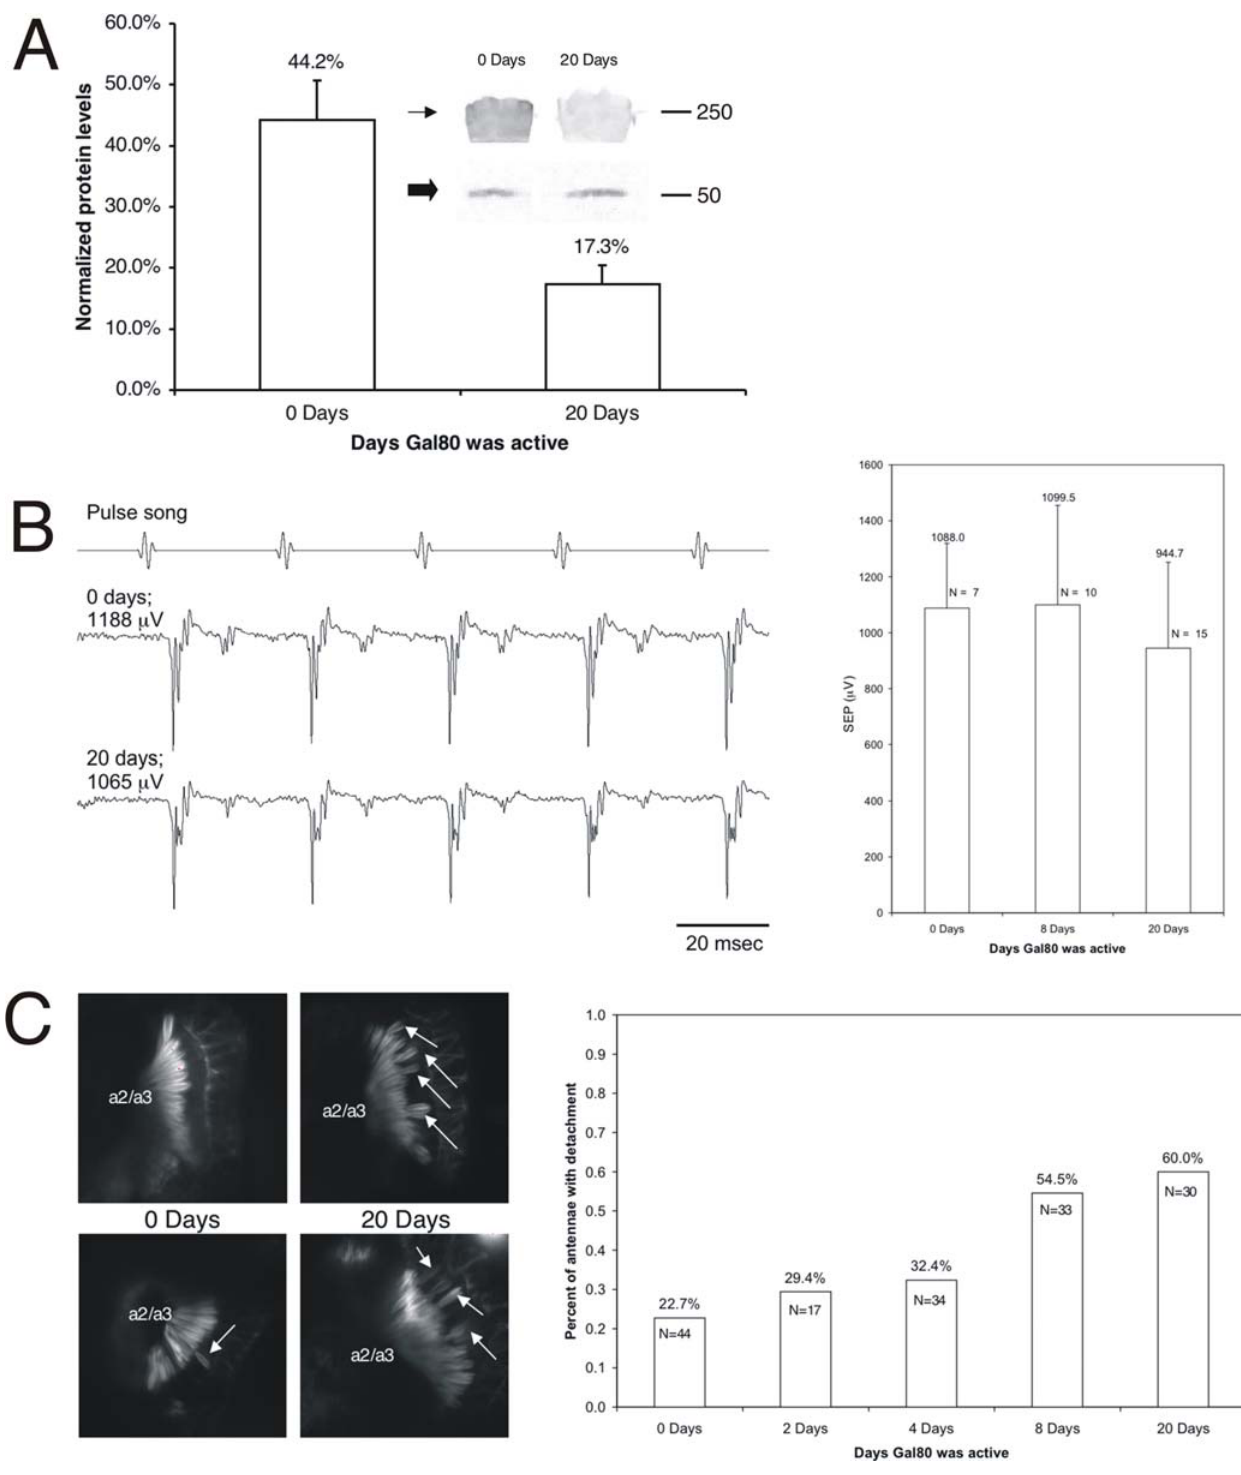
Figure 4. ck /MyoVIIA is important for maintaining adult JO organization. A: Histogram of densitometry analysis of the western blot (inset) staining for ck /MyoVIIA (arrow) and b -tubulin (block arrow; loading control) from flies with active Gal80 for 0 or 20 days. Mean + / 2 SD; N=4. B: Representative electrophysiological recordings (left) from the antennal nerve of flies with active Gal80 for 0, 8 or 20 days show no significant difference. Right: histograms of recordings. Mean + / 2 SD. C: JO organization in adults. Arrows indicate detachment. Histograms show percent of antennae with detached scolopidia.